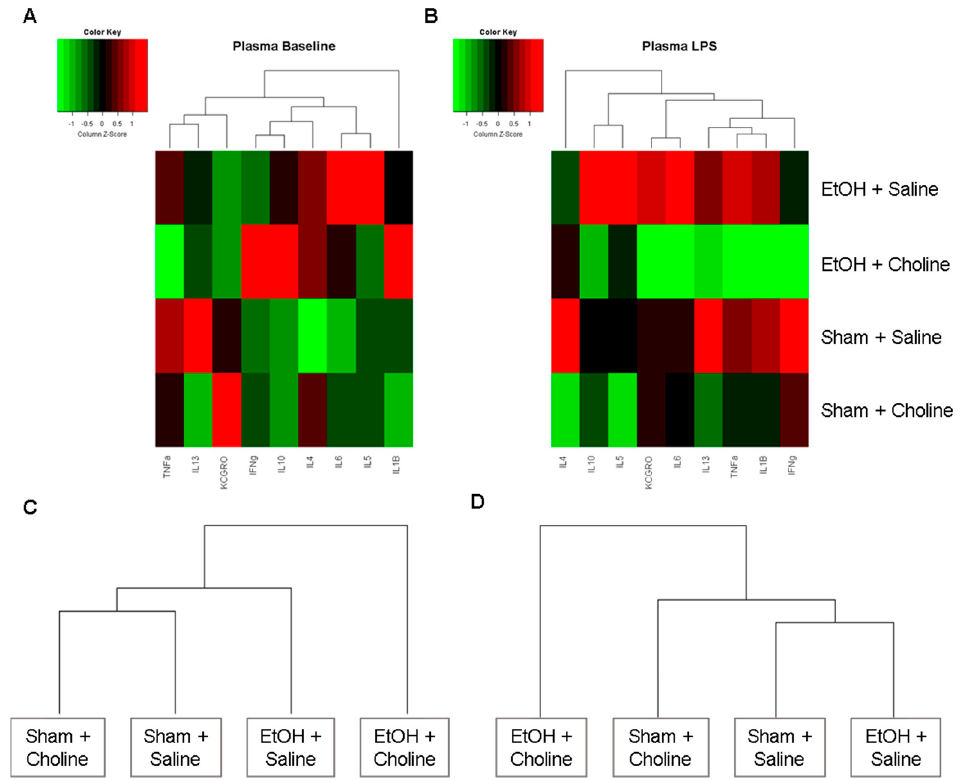
Figure 5. Overall plasma cytokine profiles. Heatmaps depicting overall cytokine profiles in the plasma in each group at ( A ) baseline and ( B ) after LPS immune challenge. Rows represent treatment groups and columns represent hierarchical clustering of mean cytokine levels (z-scored data). Additional dendrograms depict clustering of the treatment groups based on plasma cytokine profiles at ( C ) baseline and ( D ) after LPS immune challenge.